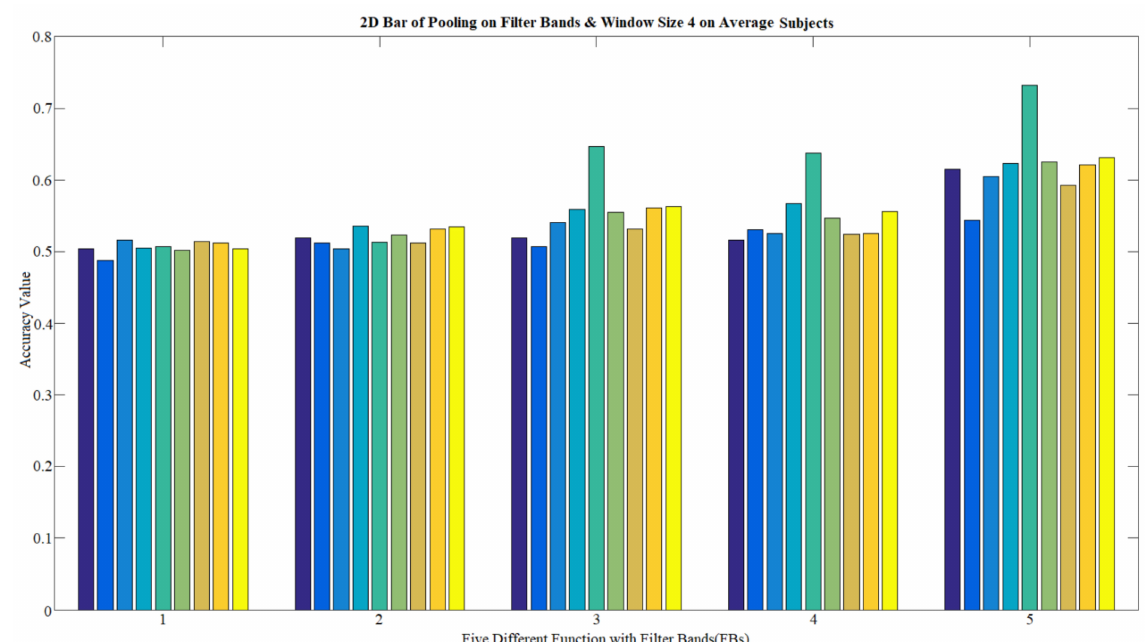
Figure 9. Reduction data based on pooling model on average subjects with filter banks and window size 4 and RF for 10